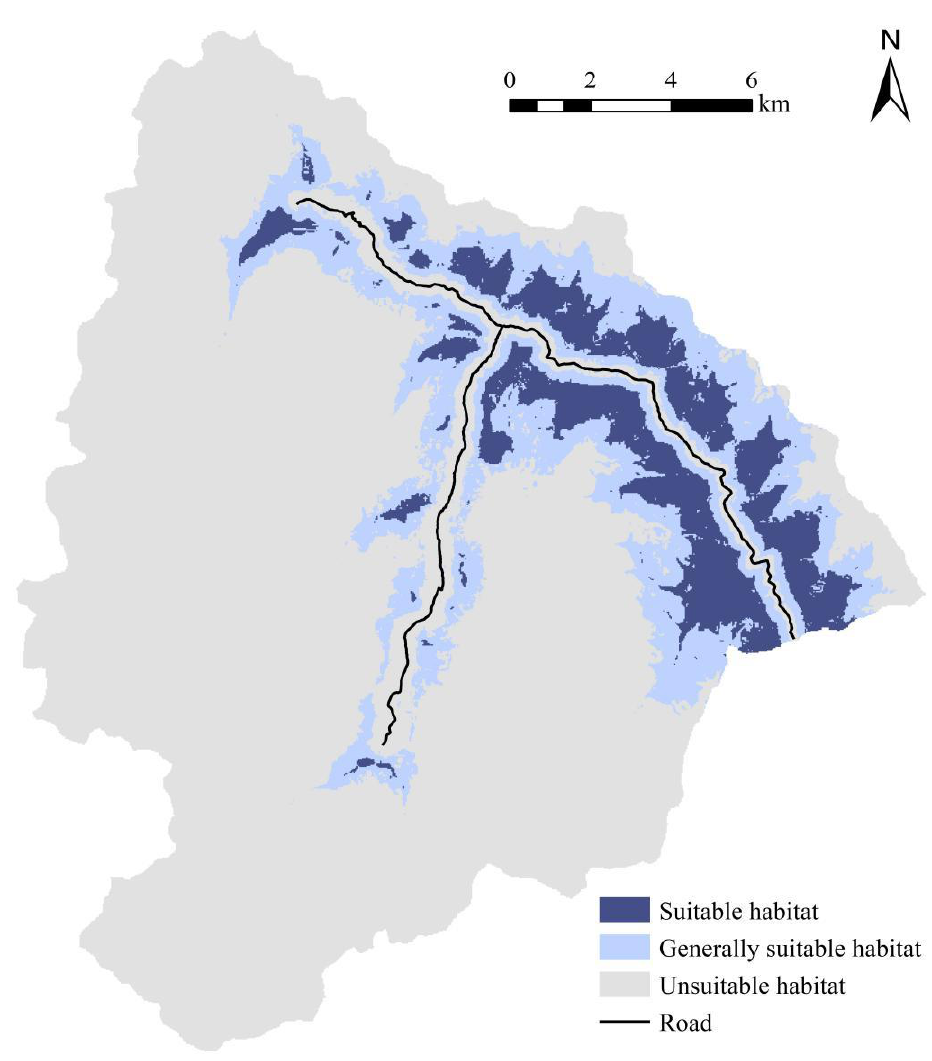
Figure 3. Suitability map of path habitats in the Wanglang Nature Reserve.